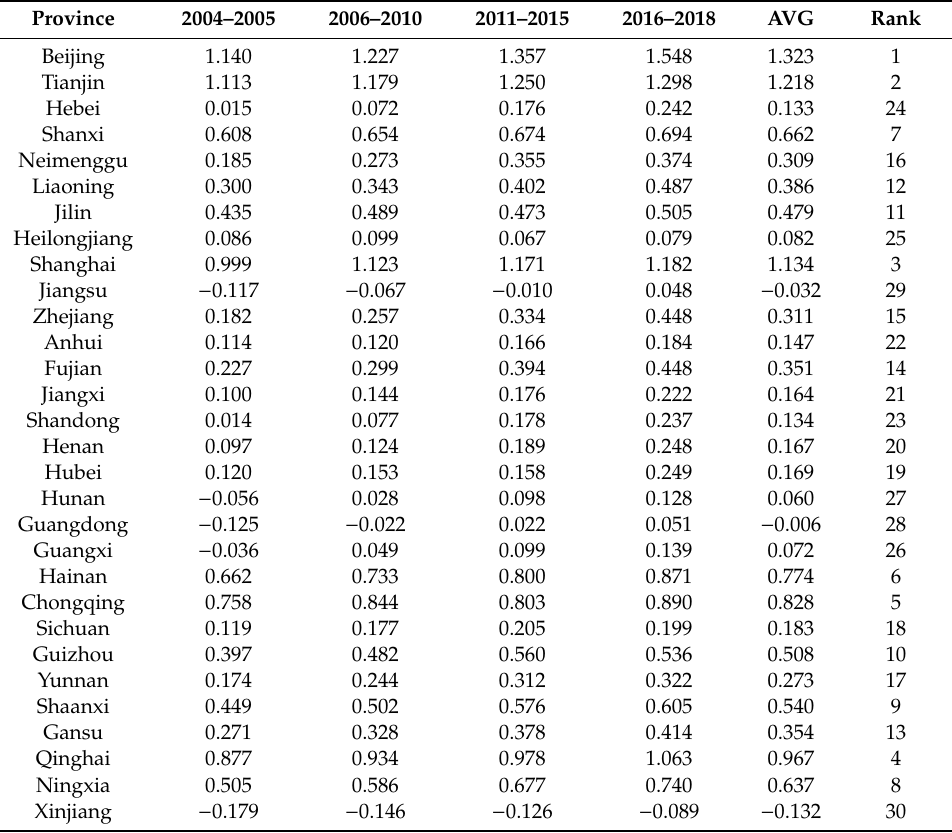
Table 5. The output elasticity of water of 30 provinces in China (2004–2018). Province